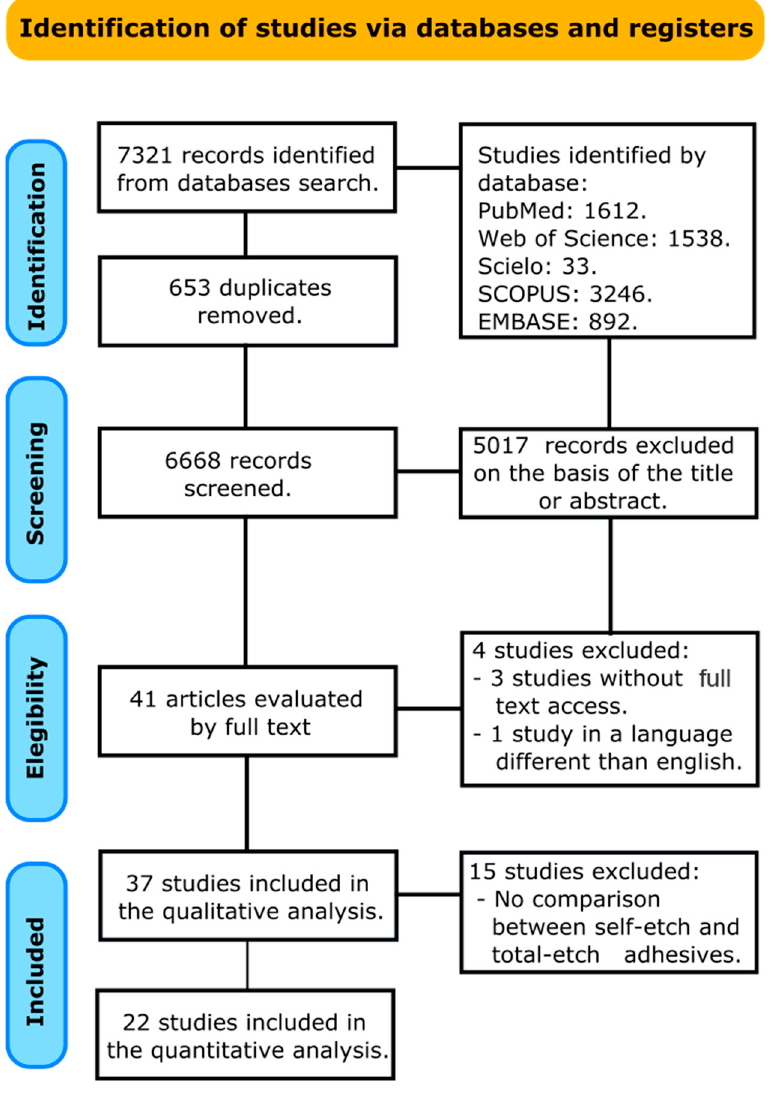
Figure 1. Search flowchart according to the PRISMA Statement.